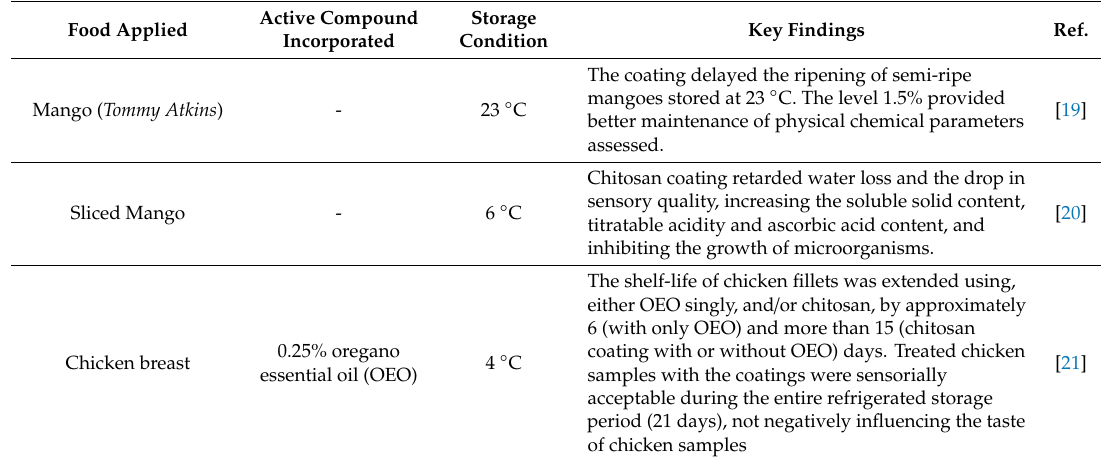
Table 1. Chitosan edible coatings